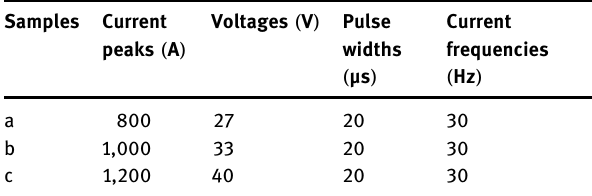
Table 1: Parameters of di ff erent pulse currents Samples